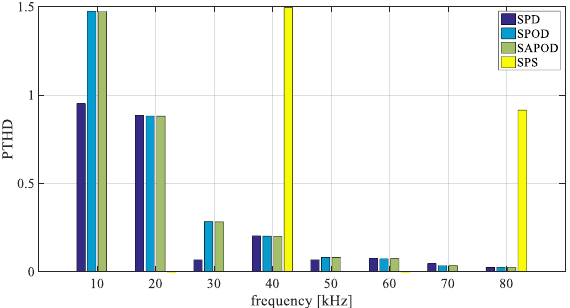
Figure 15. Comparison of PTHD values for modulation index equal to 0.5.